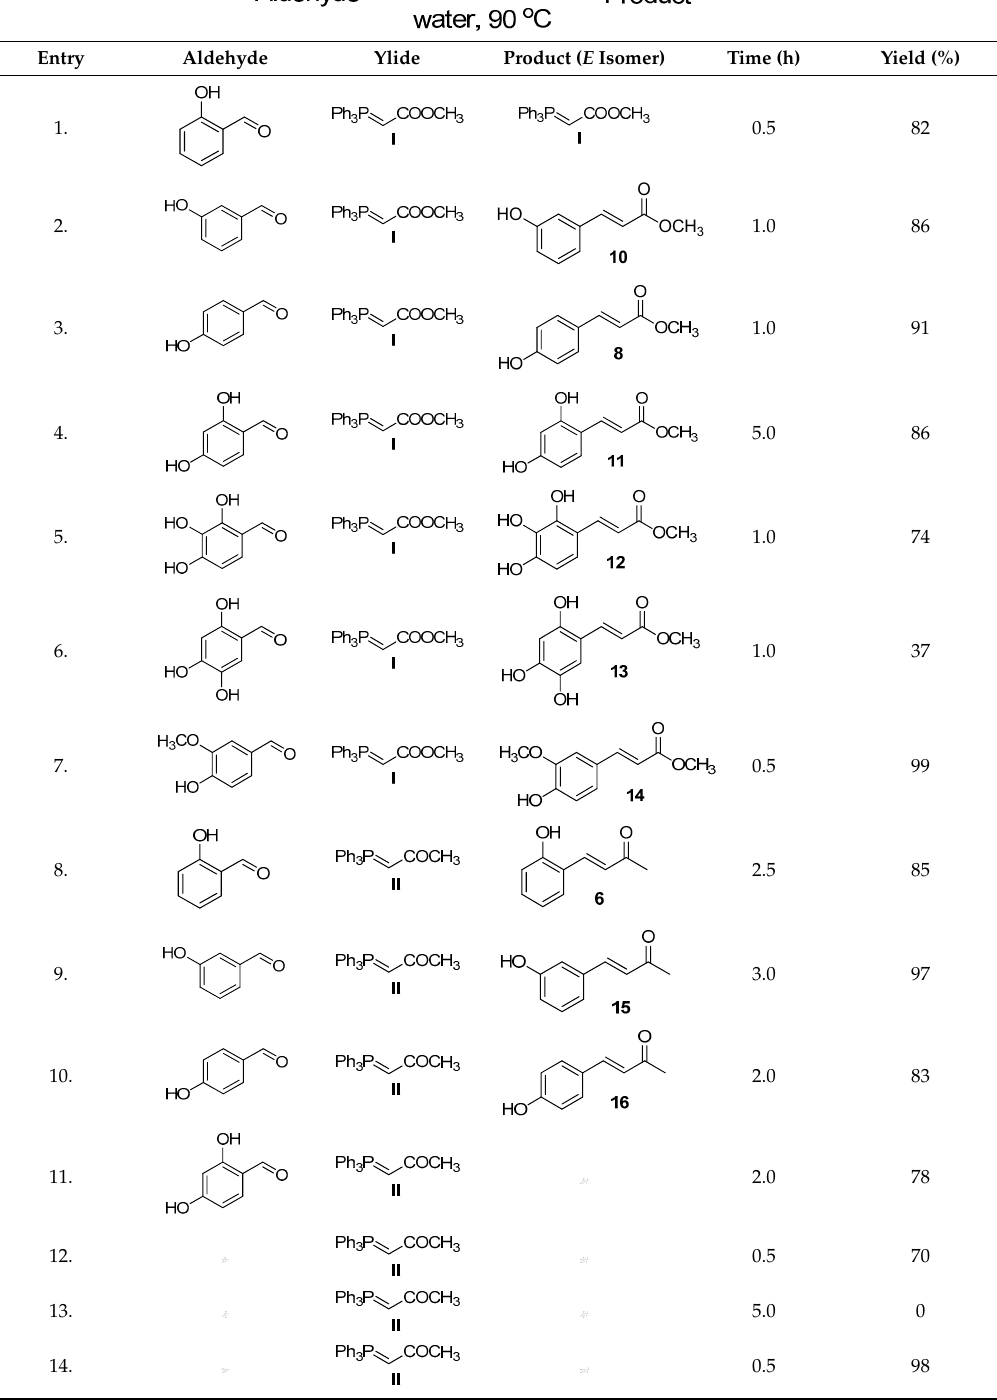
Table 1. The Horner–Wadsworth–Emmons (HWE) reaction of different aromatic aldehydes in water.